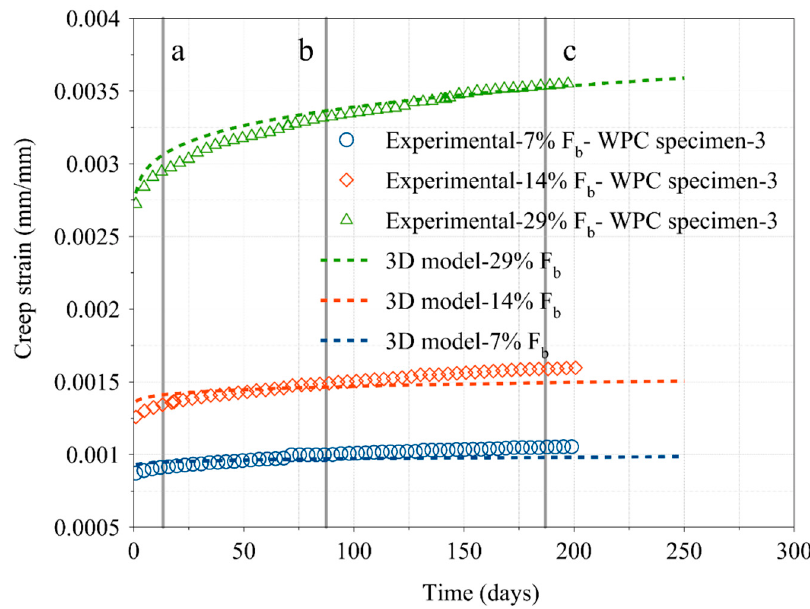
Figure 3. Typical experimental flexural creep strain of WPC specimens subjected to three levels of stress (7% Fb, 14% Fb, and 29% Fb) and the corresponding Norton-Bailey power low model prediction.